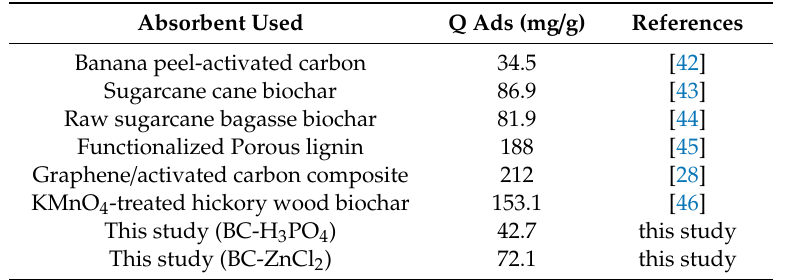
Table 4. Summary of the Pb (II) adsorption capacities of different carbonaceous materials.